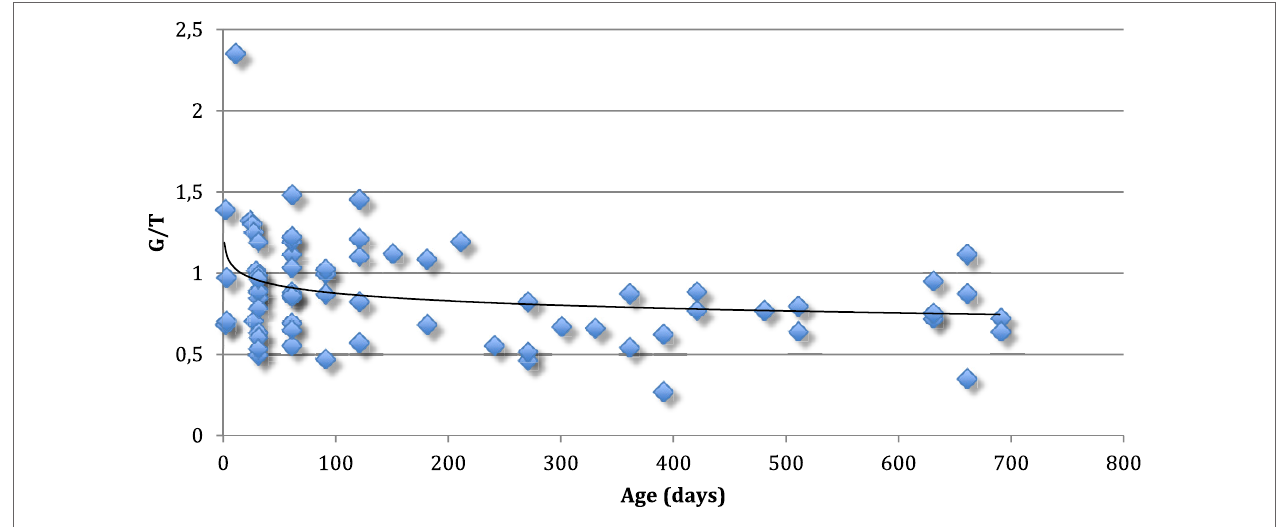
FigUre 1 | Mean germ cell number per tubular cross-section (G/T) of the testes from 69 normal boys up to 2 years of age. Every boy is represented with one value. The line represents median G/T for every